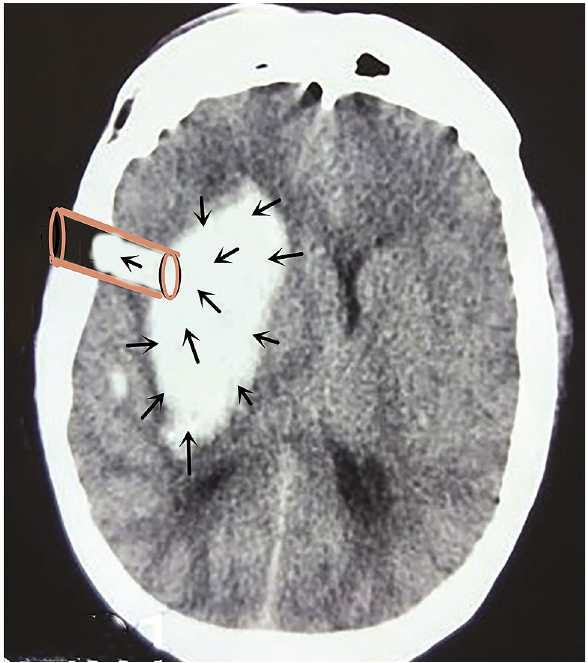
Figure 4. In the keyhole endoscopy group, the hematoma in the endoscopic channel has negative pressure relative to the remaining hematoma and brain tissue, thus forming a pressure gradient of “brain-hematoma- endoscopic channel”. Thus, the brain tissue further retracts, forcing the intracerebral hematoma to shift into the work channel area, and hematoma removal can be completed under synthetic action without any extraneous tissue